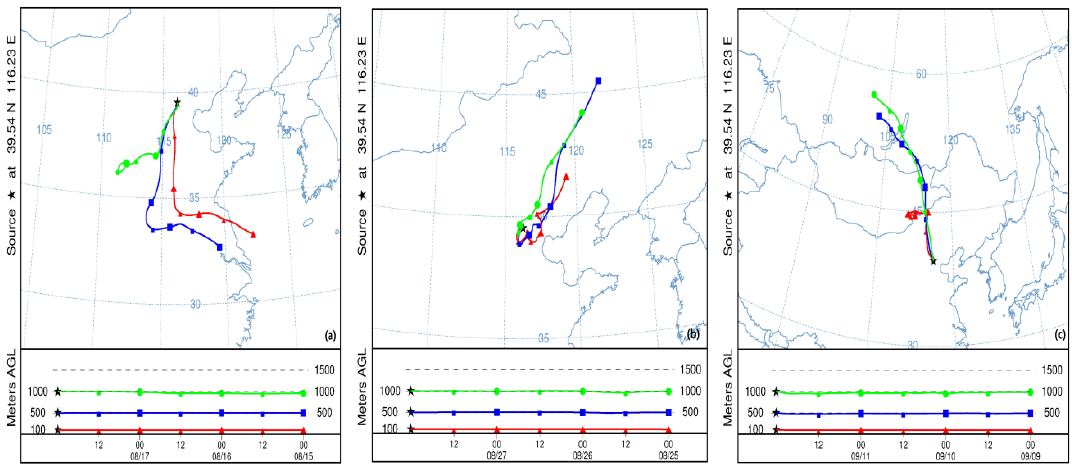
Figure 12. The 72-h backward air trajectories arriving at three hights in Beijing local time at ( a ) 08:00 on 18 August; ( b ) 08:00 on 28 August; and ( c ) 08:00 on 12 September.